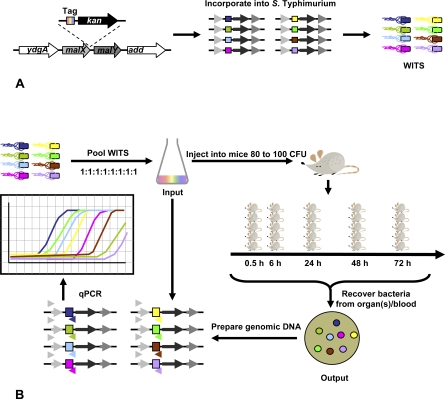
A Cartoon Detailing the Construction of the WITS and the Experimental Design(A) To investigate the in vivo population dynamics of S. enterica during systemic infection, we generated a series of WITS. These are S. enterica strains each carrying a different 40-bp ([NK]20 : N = A, C, G, or T; K = G or T) signature tag [29] in precisely the same noncoding region of the chromosome (between two pseudogenes malX and malY). Each mutant differs from the others only in that it carries a different tag, thus there should be no selective advantage between the different mutants.(B) Mice were inoculated i.v. with approximately 80 to 100 CFU of S. Typhimurium, being approximately equal CFU of each of eight WITS. At 0.5, 6, 24, 48, and 72 h p.i., groups of mice were killed, and the livers, spleens, “other organs” (kidneys, heart, lungs, and mesenteric lymph nodes), and blood were cultured for the presence of bacteria. All bacterial colonies were scraped from the agar plates, and chromosomal DNA was purified using standard commercial kits. The S. enterica population structure in individual organs at different times after i.v. inoculation was detected using quantitative PCR. Each biological sample was assessed by qPCR using each of the eight primer pair combinations, the number of copies of each WITS chromosomal DNA per reaction (biological sample) was calculated from standard curves for each of the WITS.